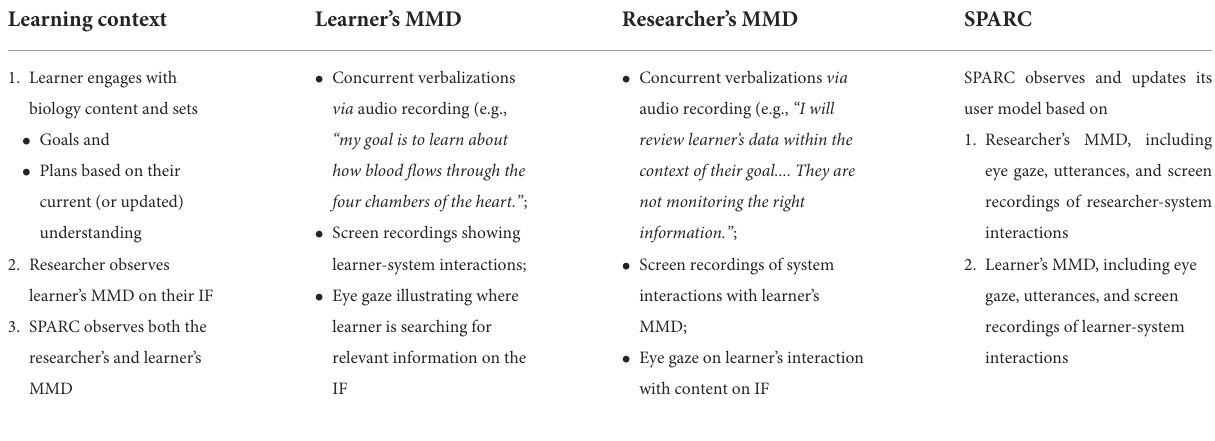
TABLE 1 Learner’s and researcher’s multimodal SRL data aligned with phase 2 of Winne’s model of SRL and corresponding instructional strategies based on umambiguous signals in data. Learning